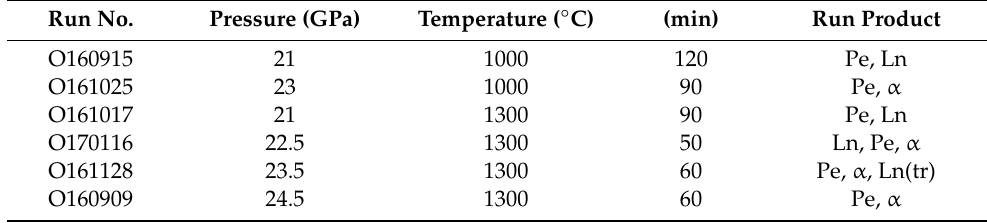
Table 1. Results of high-pressure and high-temperature experiments in Mg 2 TiO 4 . Run